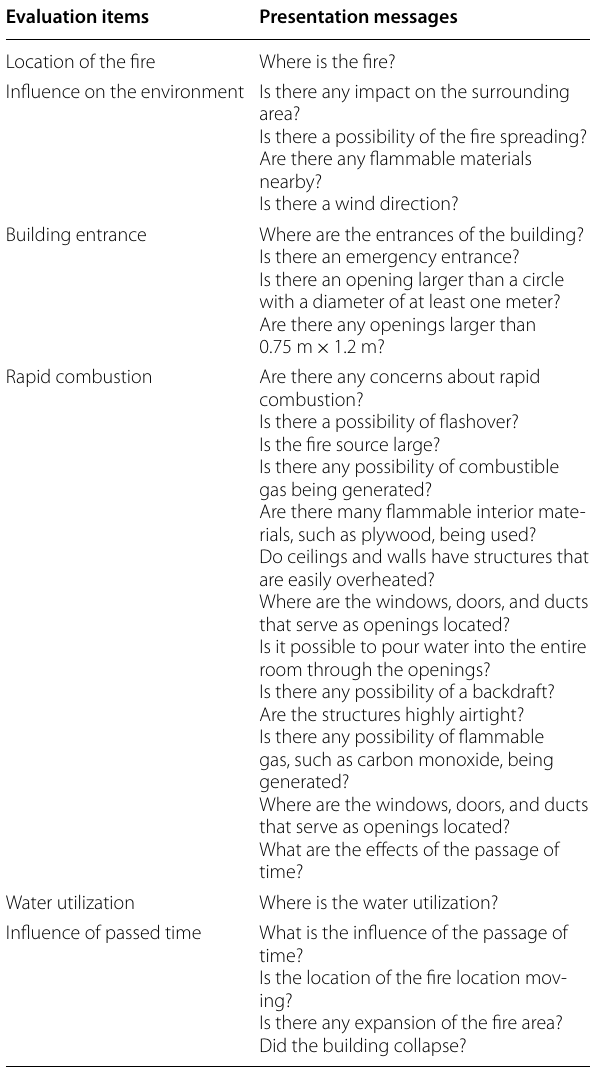
Table 8 Presentation messages during the